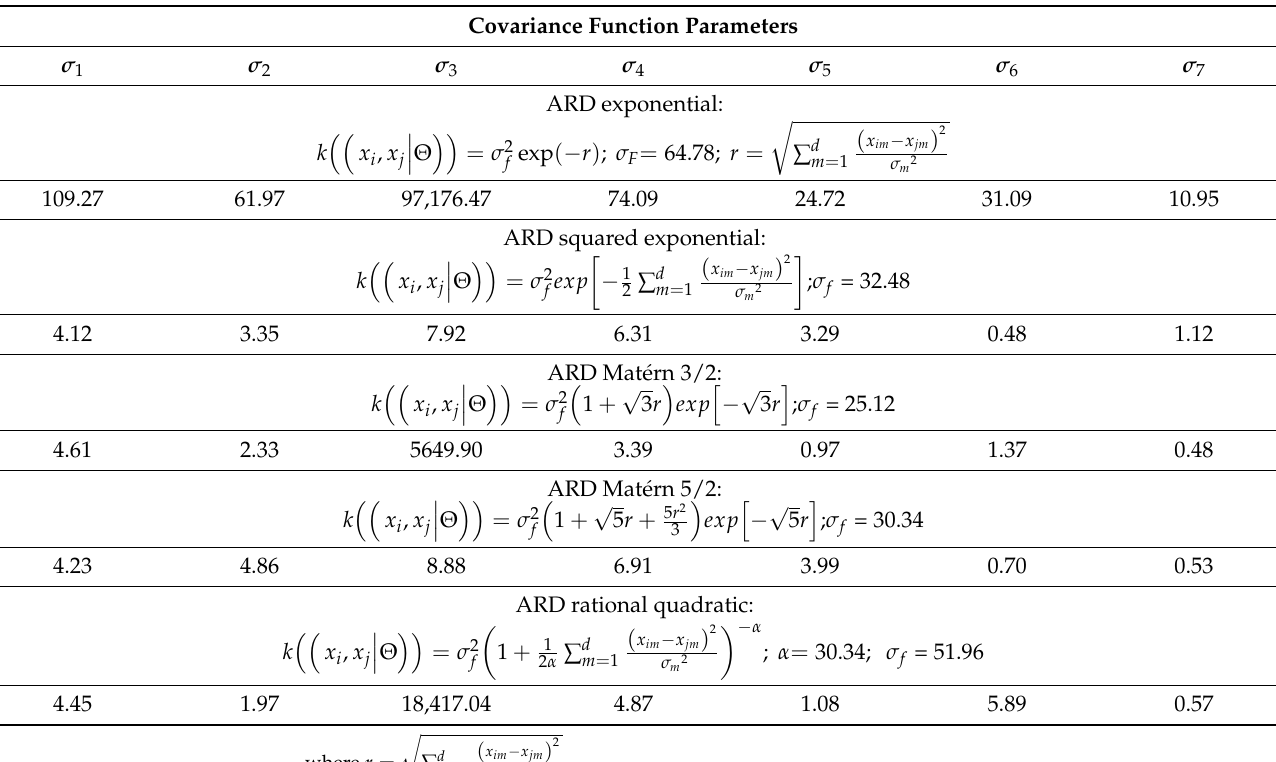
Table 8. Values of optimal parameters in GPR ARD models with different covariance